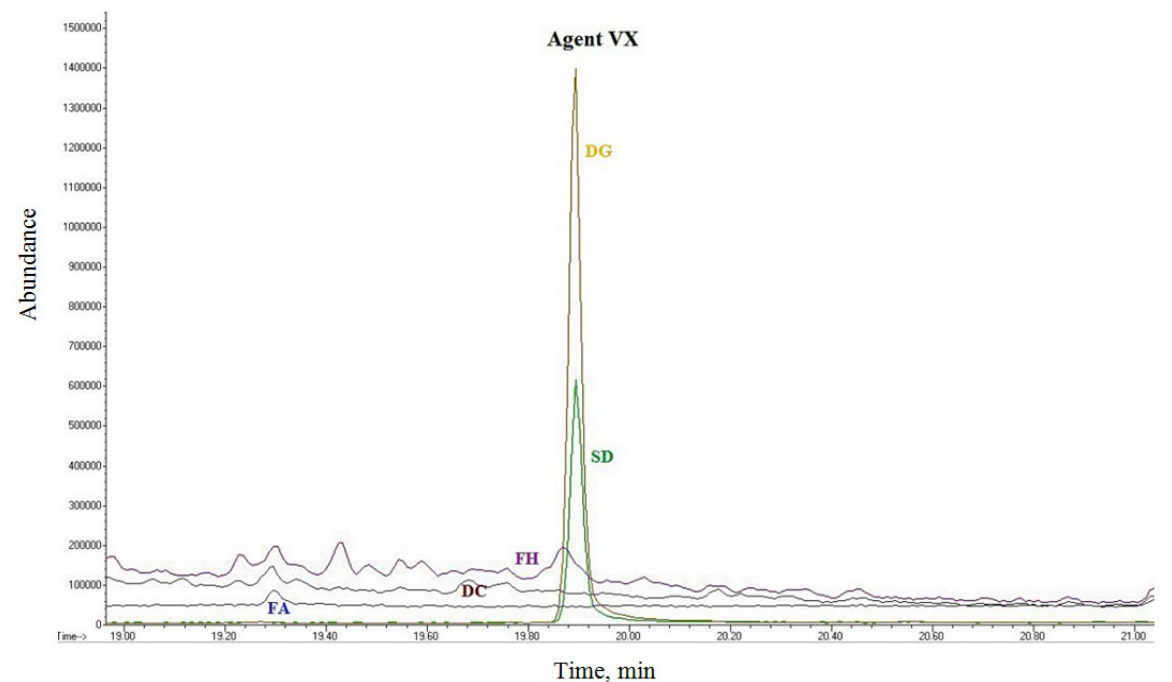
Figure 6. GC/MS chromatogram of waste after decontamination of O -ethyl- S - (diisopropylaminoethyl)-methylthiophosphonate (VX) with Desprach sorbent (SD), decontamination glove (DG), FAST-ACT sorbent (FA), RSDL decontamination sponge (DC) and Hvezda foam